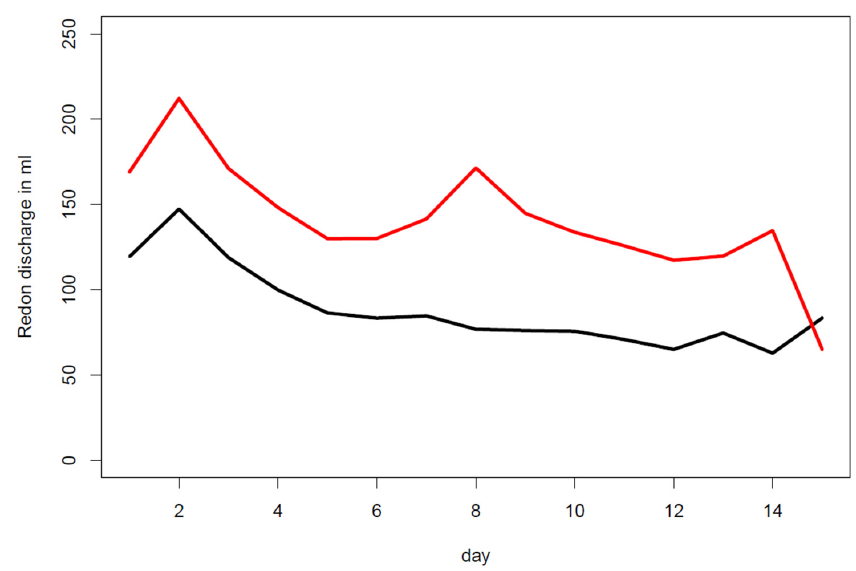
Figure 3. Average daily drainage volumes over time of patients with seroma evacuation (red curve) vs. patients not developing a seroma after drain removal (black curve). Both curves show an increase at day 2 post surgery. The drainage volume of patients who did not develop seroma declined steadily. Patients who developed a seroma showed an increase in drainage volume around day 8.